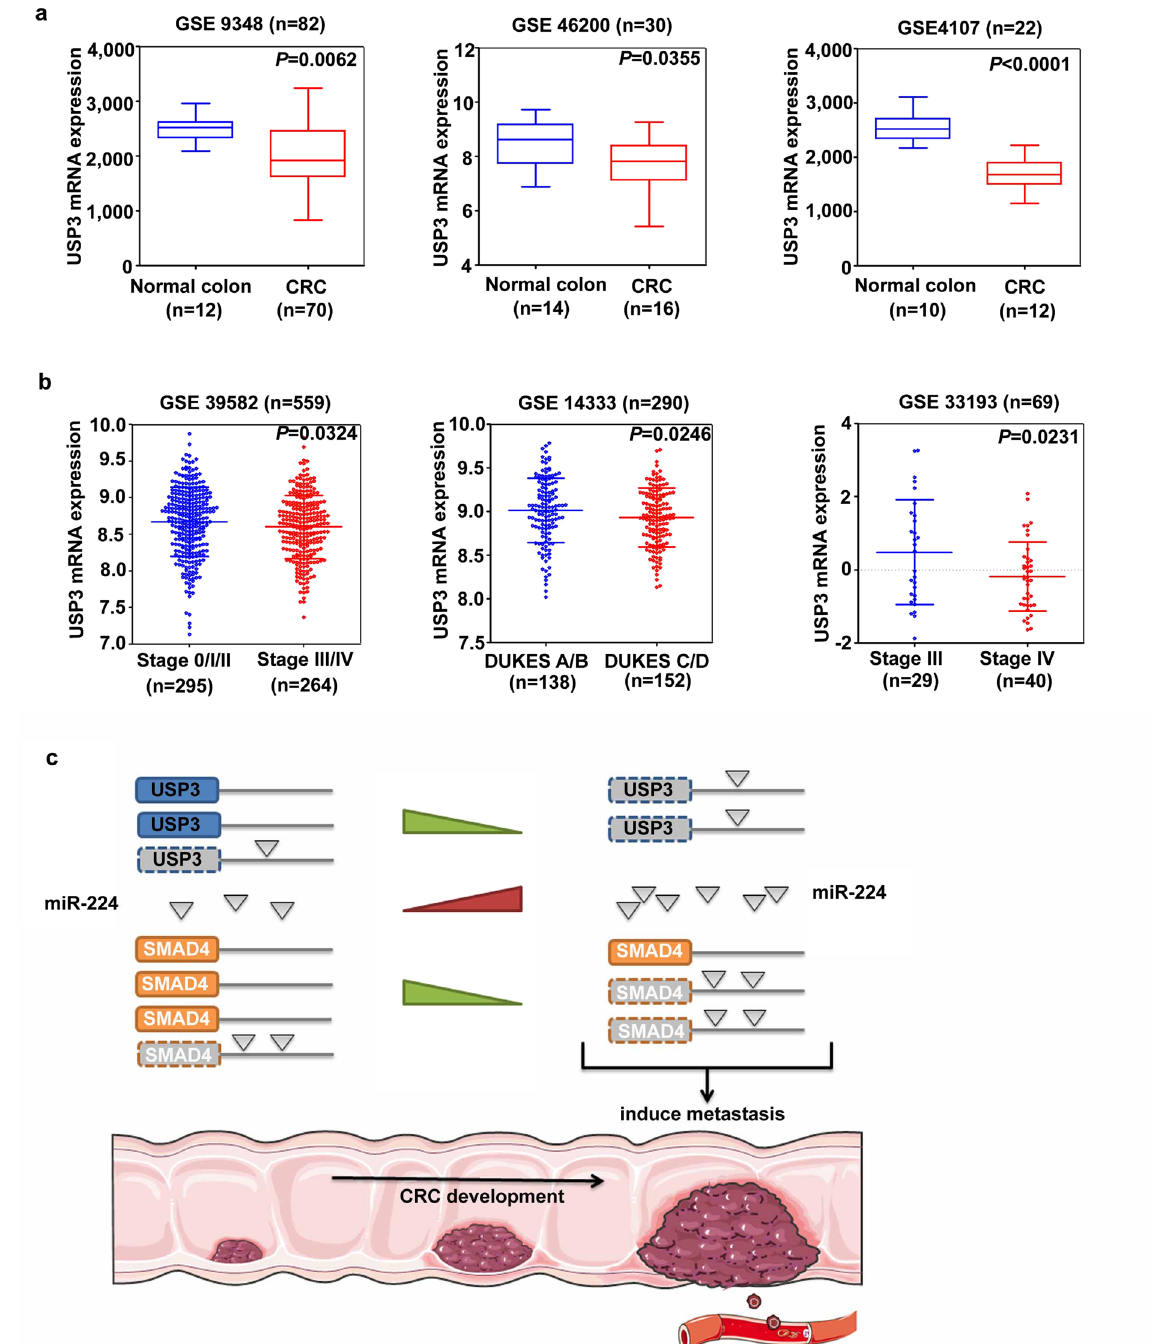
Figure 7. Analyses of USP3 mRNA expression in the CRC samples from the GEO database. ( a ) USP3 mRNA was decreased in CRCs compared with their adjacent noncancerous tissues (GEO datasets: GSE9348, GSE46200 and GSE4107). ( b ) Reduced expression of USP3 mRNA was associated with an advanced tumour stage in the primary CRC tissues (GEO datasets: GSE39582, GSE14333 and GSE33193). ( c ) A schematic model illustrates how a dysregulated USP3-miR-224-SMAD4 axis facilitates CRC metastasis during cancer